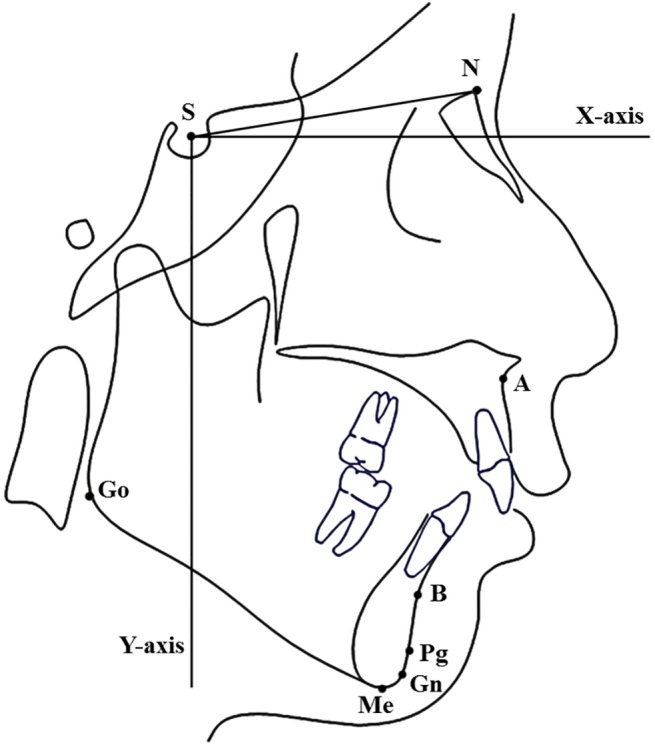
Coordinate system and hard tissue landmarks used in cephalometric analysis.